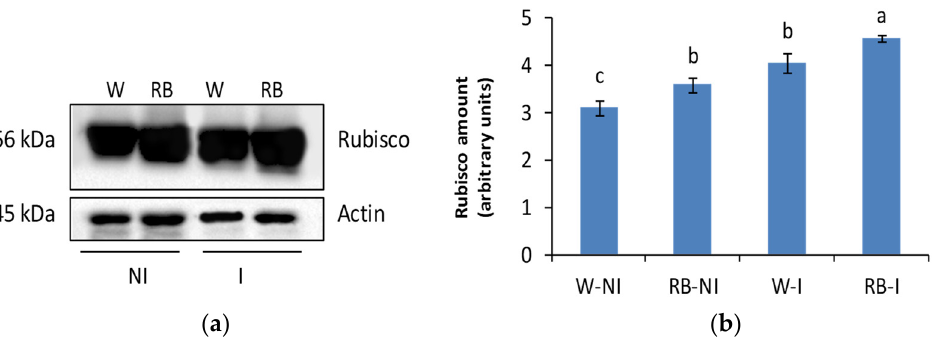
Figure 5. Western blot and densitometric analysis of Rubisco protein ( a , b ) in not-inoculated (NI) and inoculated (I) spinach plants grown under W and RB light regimes. Data are means ± standard error (n = 5). Different letters denote significant differences.